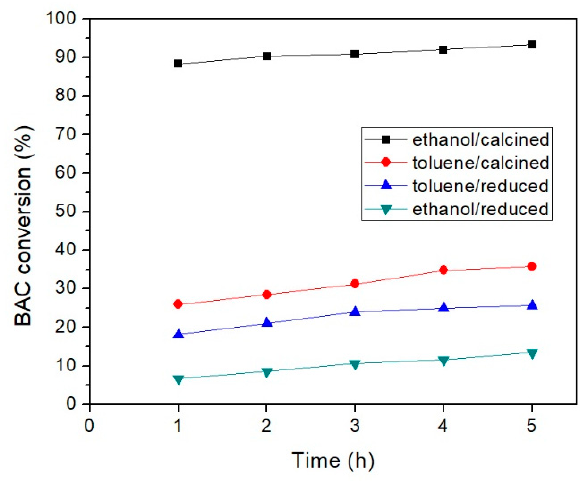
Figure 7. BnOH conversion using PdO x / CeO 2 -NR or PdO x / CeO 2 -NR-Red catalysts, as a function of time. Reaction conditions: BnOH 0.16 mmol, catalyst mass 32 mg, reaction temperature 78 ◦ C for ethanol and 111 ◦ C for